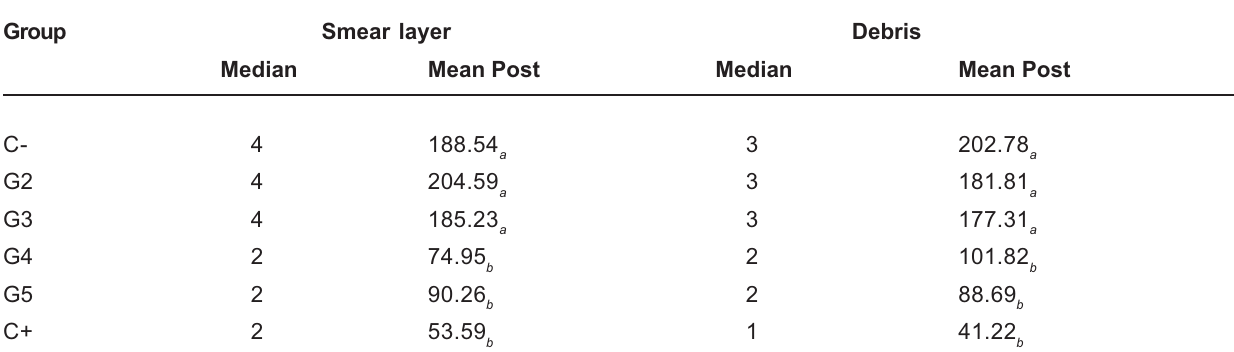
TABLE 1- Values of median and mean post for the presence of smear layer and debris for each group